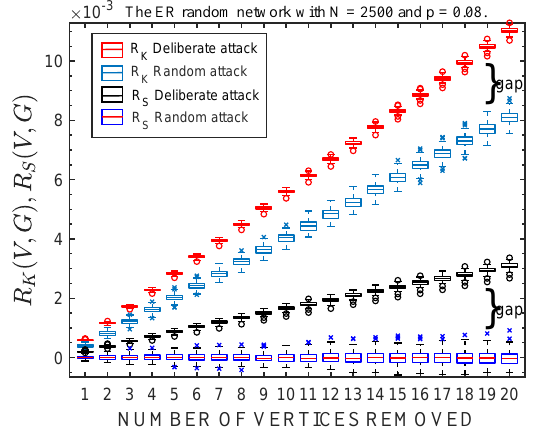
Figure 3. The figure shows the calculation and analysis of deliberate attacks and random attacks of R S ( V , G ) and R K ( V , G ) on the ER random network. They are all calculated by generating a 2500-order ER random network with p = 0.08 for 10 2 times, and the results are displayed in the form of box plots.